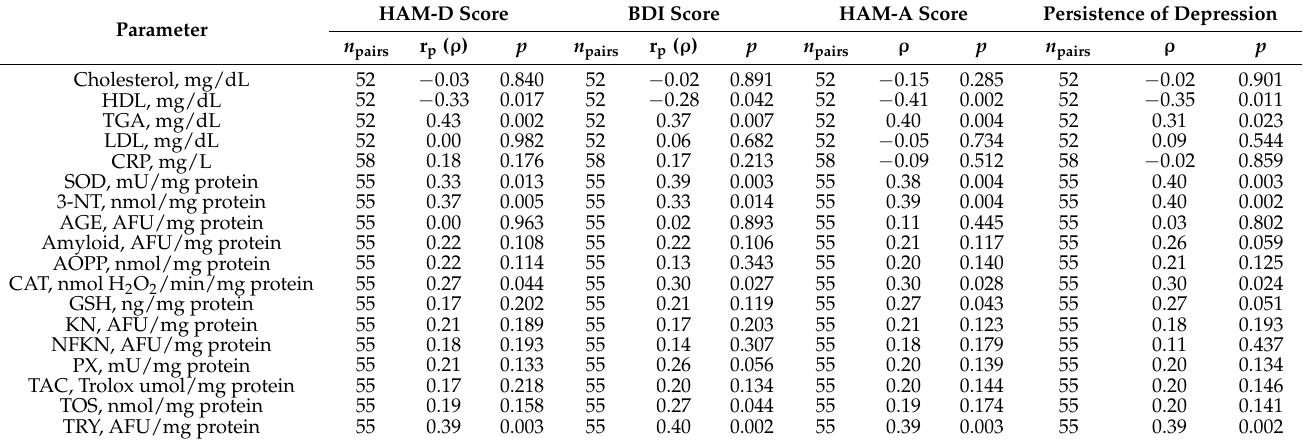
Table 2. HAM-A, HAM-D, and Beck questionnaire scores and the disease duration factor showed significant associations with serum HDL and TGA and urine SOD, 3-NT, CAT, and TRY concentra- tions. Urine GSH correlated with the HAM-A score. All significant correlations were characterized by large effect sizes. There was a negative correlation with HDL—an increase in questionnaire scores/duration of disease persistence correlated with a decrease in HDL levels. An additive rela- tionship was found with other parameters—an increase in questionnaire scores/duration of disease persistence correlated with an increase in TGA, SOD, 3-NT, CAT, TRY, and GSH levels. The factor that nearly all questionnaire scores correlated with the same parameters is explained by the fact that the questionnaire scores were highly correlated among themselves (r ≥